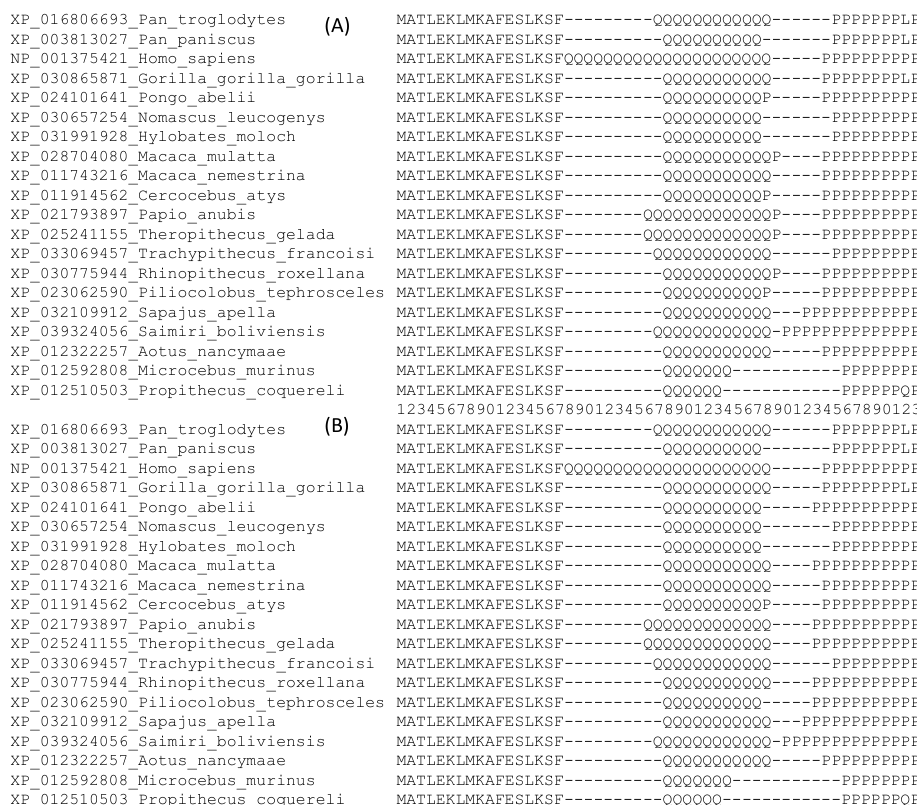
Figure 4. Illustration of PWM-based refinement of sequence alignment based on the N-terminus of 20 aligned HTT sequences, with the site numbering in the middle. ( A ) Alignment after Step 1 refinement. ( B ) Alignment after Step 2 refinement, except that the shared gap at site 39 has not yet been deleted.